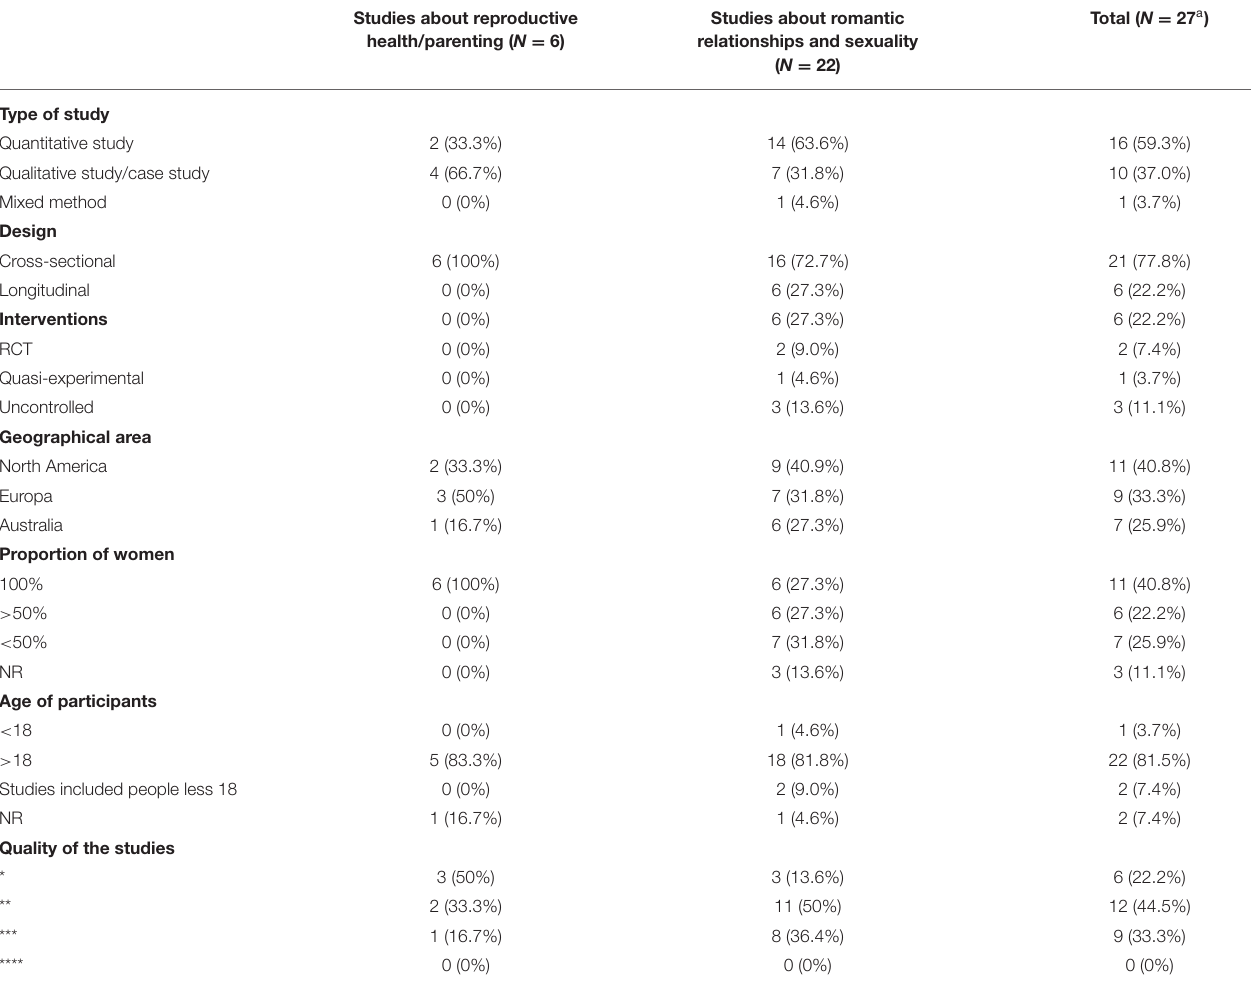
TABLE 1 | Research characteristics of the 27 studies included in the review.